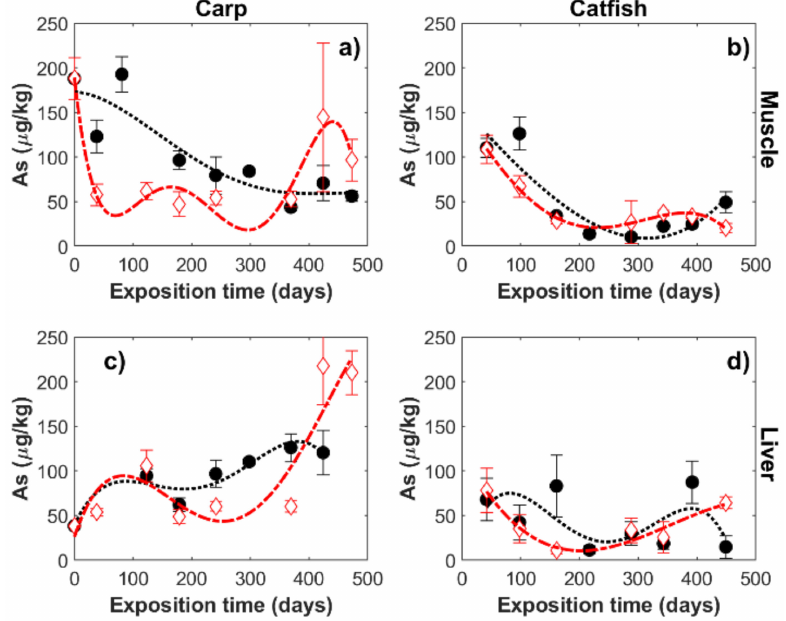
Figure 6. As accumulation in the experimental ( • ) and control groups ( carp, ( b ) muscle in catfish, ( c ) liver in carp, and ( d ) liver in catfish.